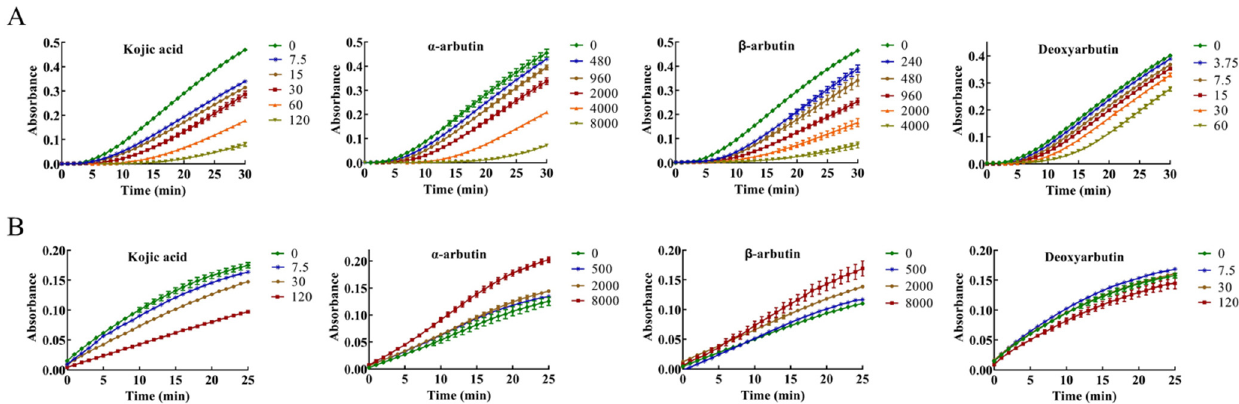
Figure 2. Progress curves of kojic acid, α -arbutin, β -arbutin, and deoxyarbutin on monophenolase and diphenolase of mushroom tyrosinase (MTYR). ( A ) Progress curves of kojic acid (7.5–120 µM), α -arbutin (480–8000 µM), β -arbutin (240–4000 µM), and deoxyarbutin (3.75–60 µM) on monophenolase of MTYR. ( B ) Progress curves of kojic acid (7.5, 30, and 120 µM), α -arbutin (500, 2000, and 8000 µM), β -arbutin (500, 2000, and 8000 µM), and deoxyarbutin (7.5, 30, and 120 µM) on diphenolase of MTYR.